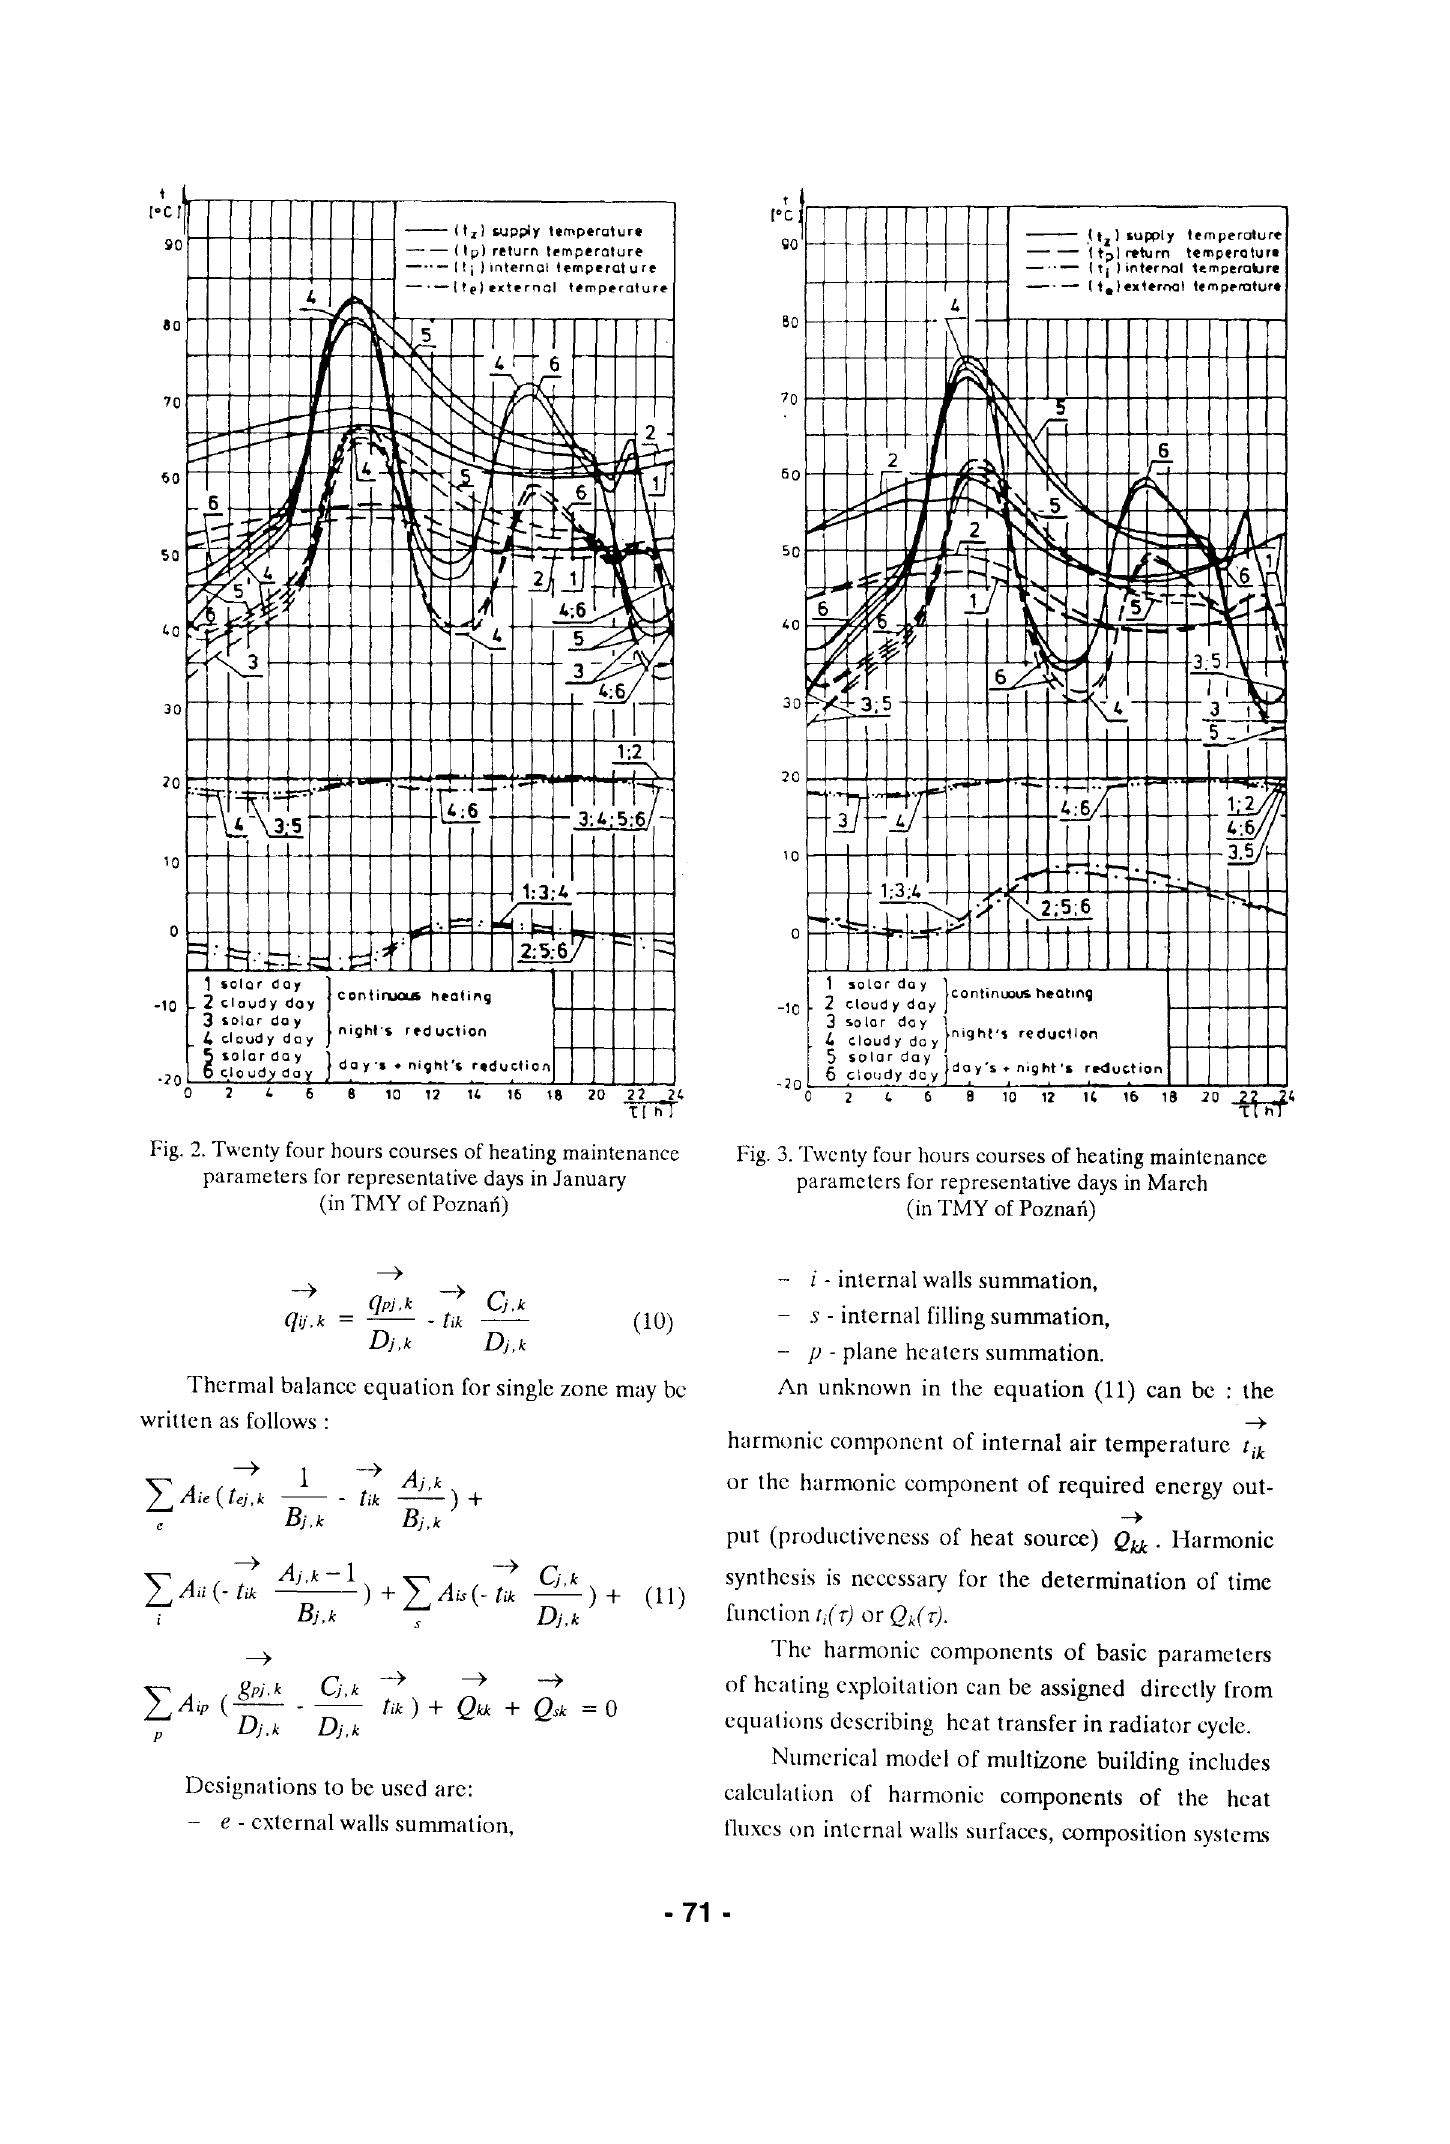
- p- plane heaters summation. An unknown in the equation (11) can be the harmonic component of internal air temperature tik or the harmonic component of required energy out- ~ put (productiveness of heat source) Qkk . Harmonic synthesis is necessary for the determination of time function tt(r) or Qd r). The harmonic components of basic parameters of heating exploitation can be assigned directly from equations describing heat transfer in radiator cycle. Numerical model of multizone building includes calculation of harmonic components of the heat t1uxcs on internal walls surfaces, composition